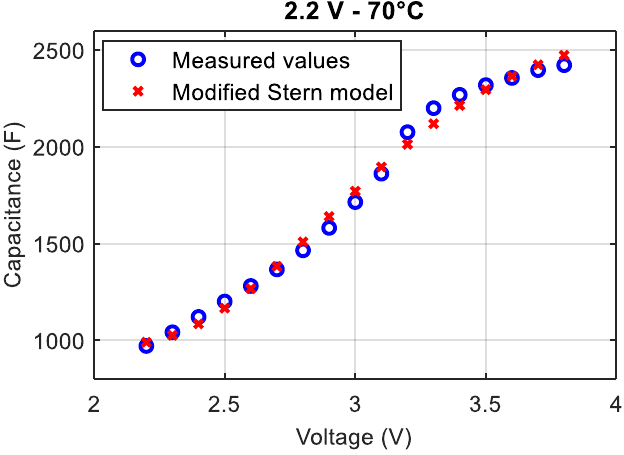
Figure 6. Batteries 2020 , 6 , x FOR PEER REVIEW